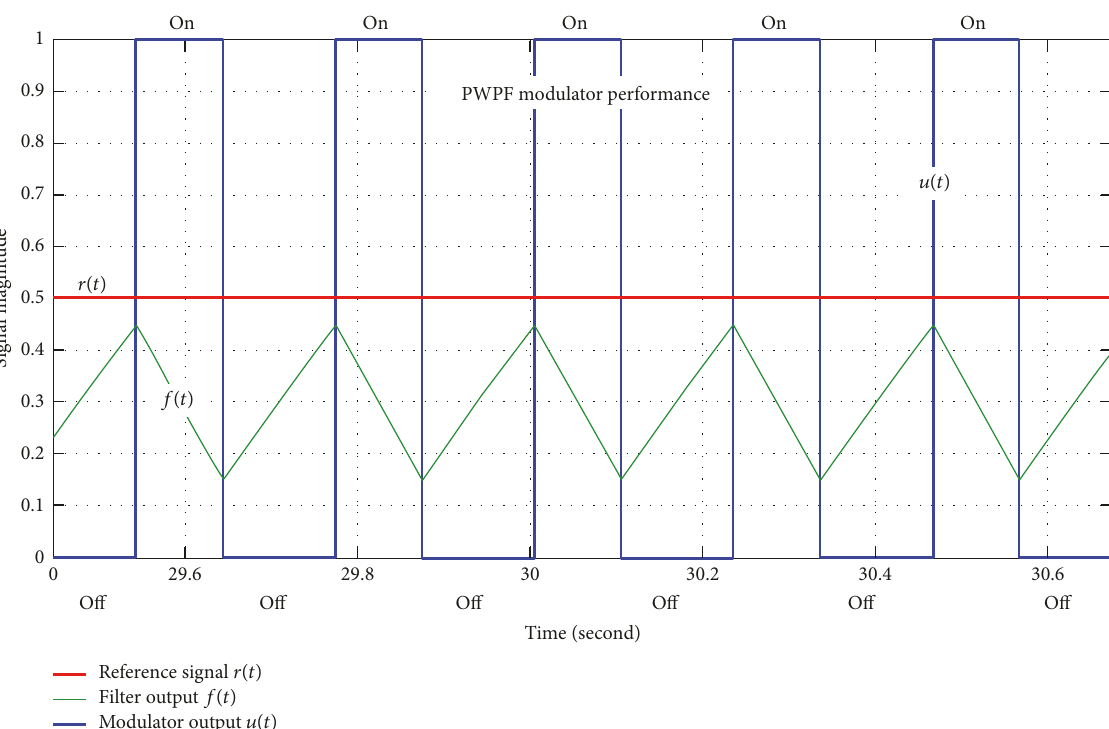
Figure 6: PWPF modulator response to 𝑡 fixed input 𝐶 = 0.5